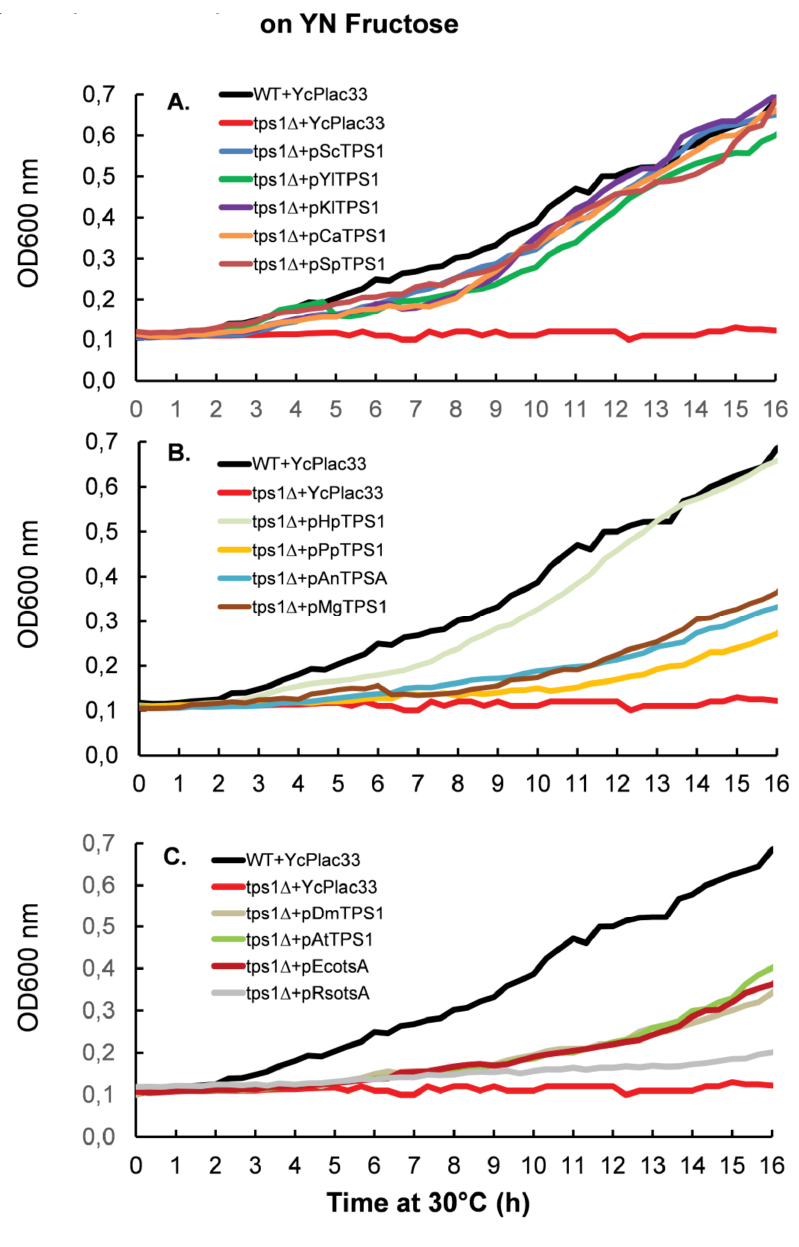
FIGURE 4: Resumption of growth of S. cerevisiae tps1 mutant transformed with TPS1 from different organism on YN fructose media in microtiter plate. (A) Complementation of sctps1 with TPS1 homologs from yeast species. (B) Com- plementation of Sctps1 with TPSD1 homo- logs from P. pastoris , H. polymorpha and the filamentous fungi A. niger and M. grisea . (C) Complementation of sctps1 with TPS1 homologs from bacteria, plants and drosophila. The experimental design was as in Fig.2 except that the yeast cells were inoculated in 250 µL of YN containing fructose at 2% (w/v). For the sake of clari- ty, standard deviation bars have been withdrawn, but overall the SD was in the range of 10 -15